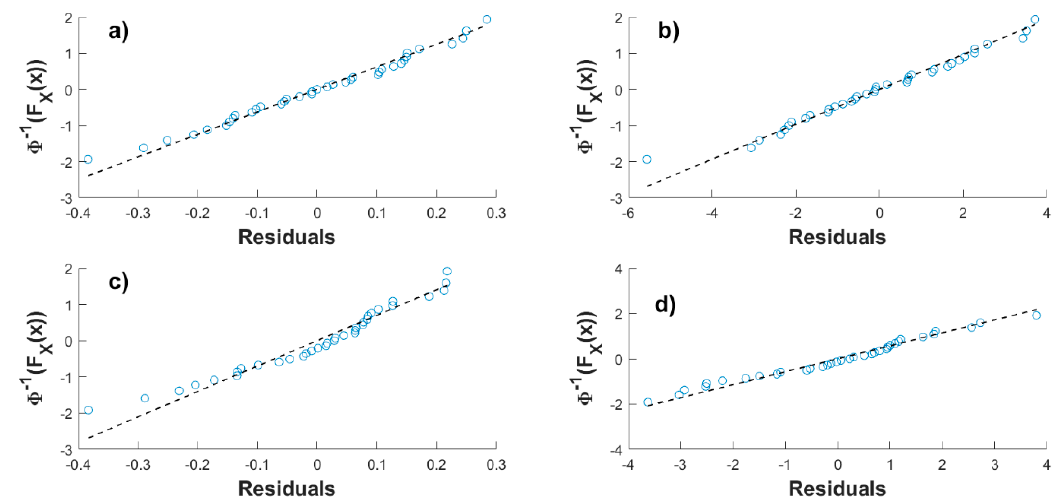
Figure 4. Normal probability papers for residuals. October: ( a ) nonlinear model and ( b ) linear model. February: ( c ) nonlinear model and ( d ) linear model.